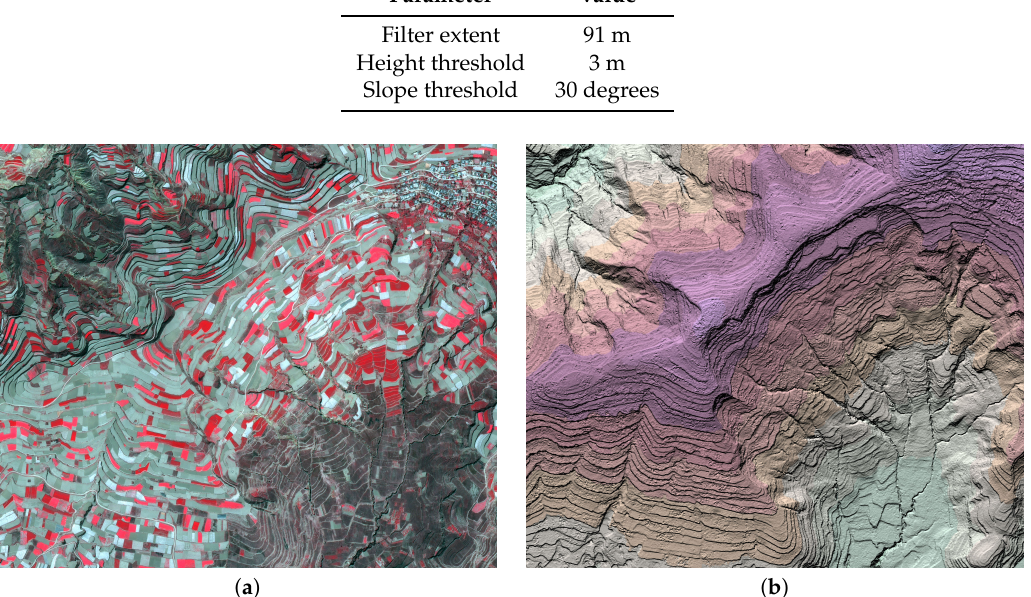
Figure 25. Ortho CIR image ( a ) and relief shaded DSM ( b ) are visualized for a subset of the Tian Shui test site covering 3.4 km 2